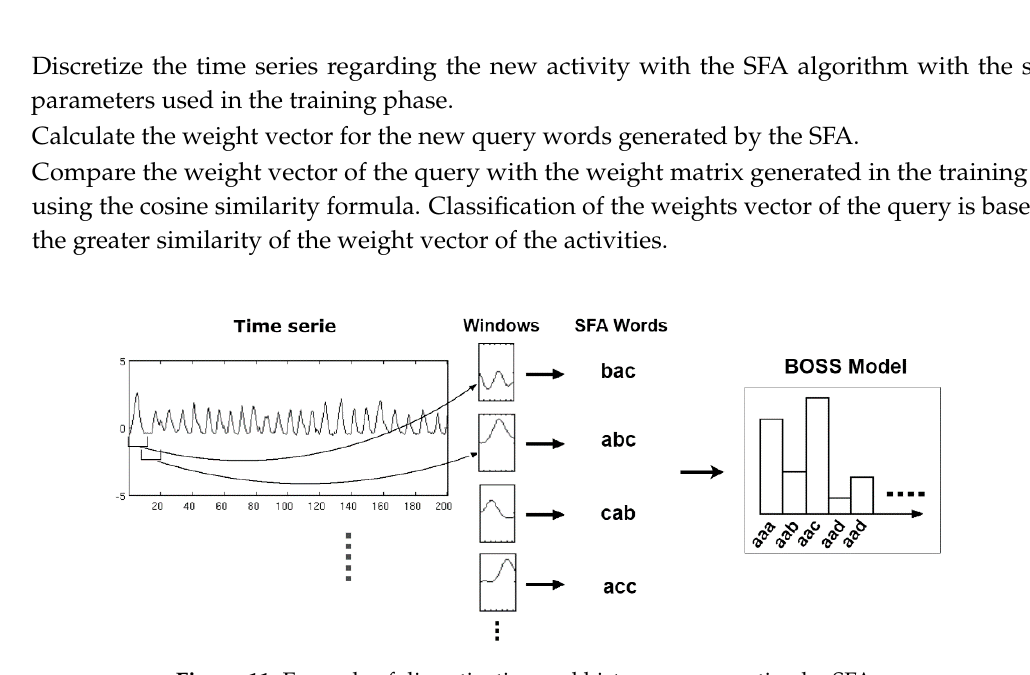
Figure 11. Example of discretization and histogram generation by SFA.